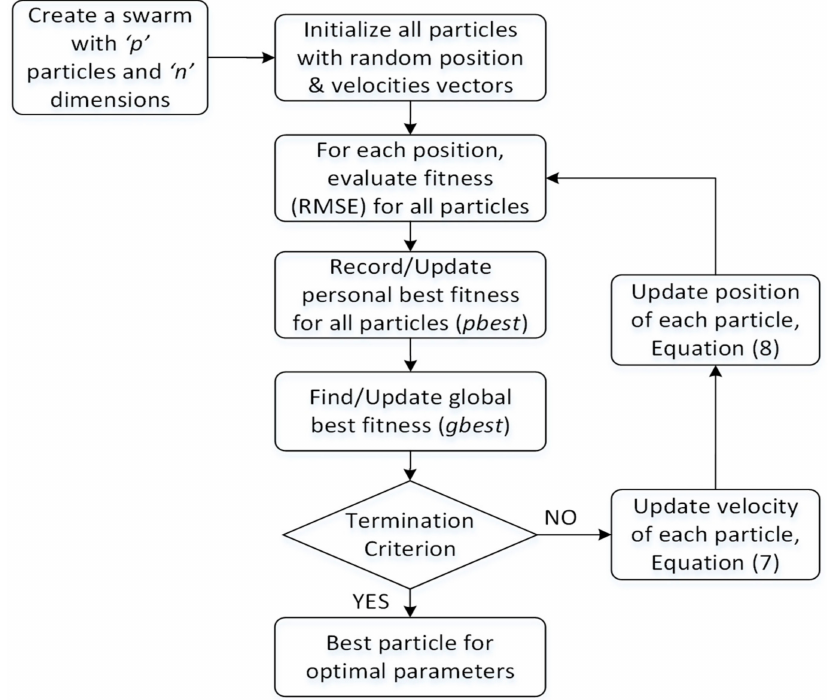
Figure 4. Flowchart algorithm for particle swarm optimization